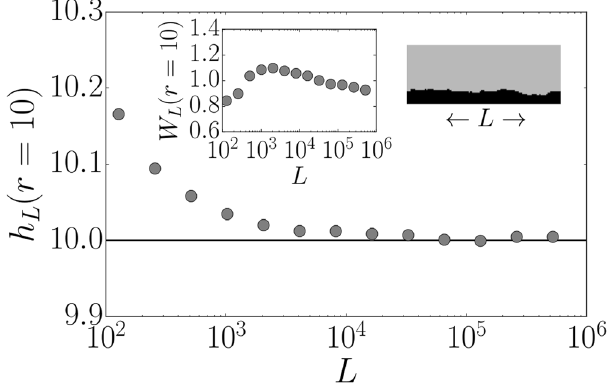
Figure 3. Surface height and width of the confined epidemic. The surface height = h r ( 10) function of the linear system size ∈ … L {2 , 2 , , 2 } 6 7 19 of a square lattice. For the smallest system with = L 64 , the number of samples is 10 4 . As the system size doubles, the number of samples is divided by 2. A typical rectangular interface structure is shown in the upper right inset. Black lattice sites are infected. The width = W r ( 10) as a function of L is shown in the upper left inset. Error bars are smaller than the marker sizes. L